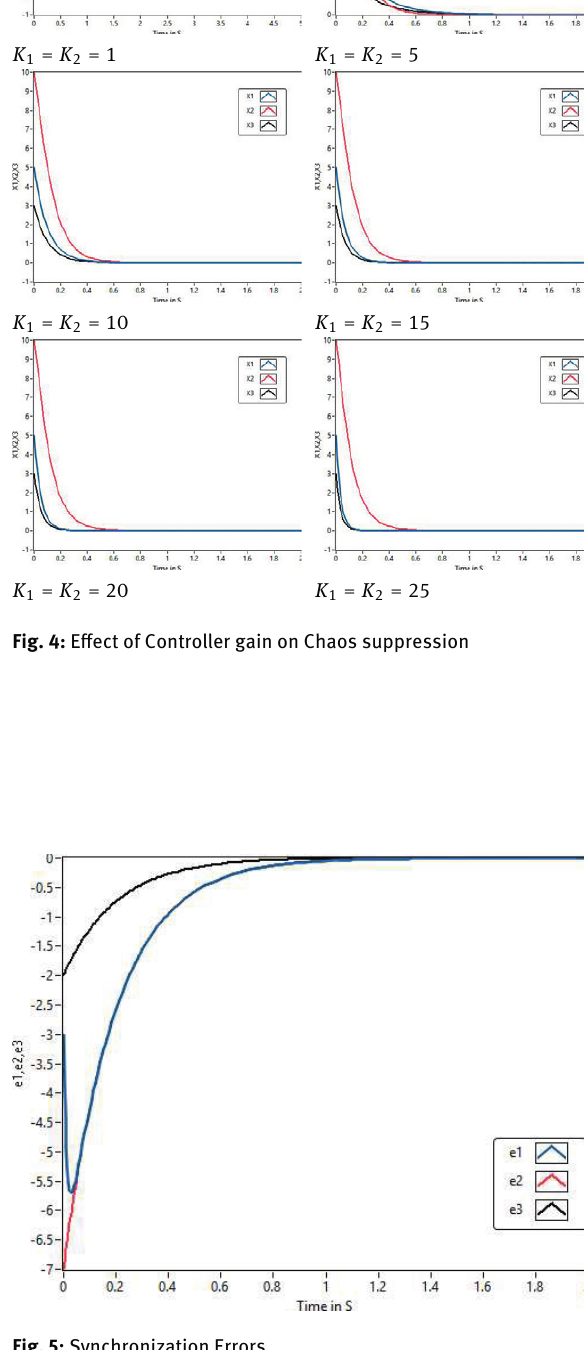
Fig. 5: Synchronization